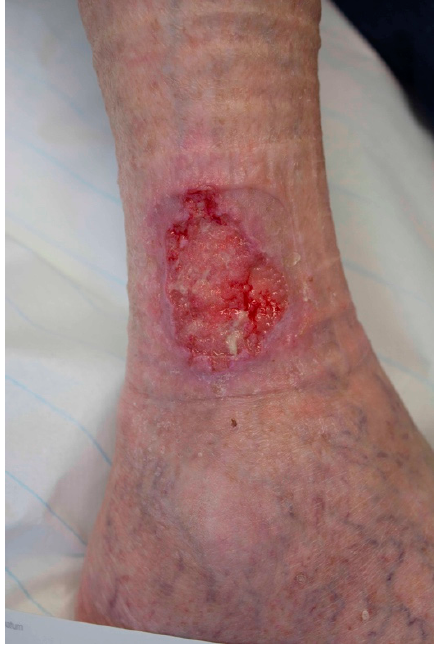
Figure 5. Example of a BCC on the lateral gaiter area, misdiagnosed as a chronic venous